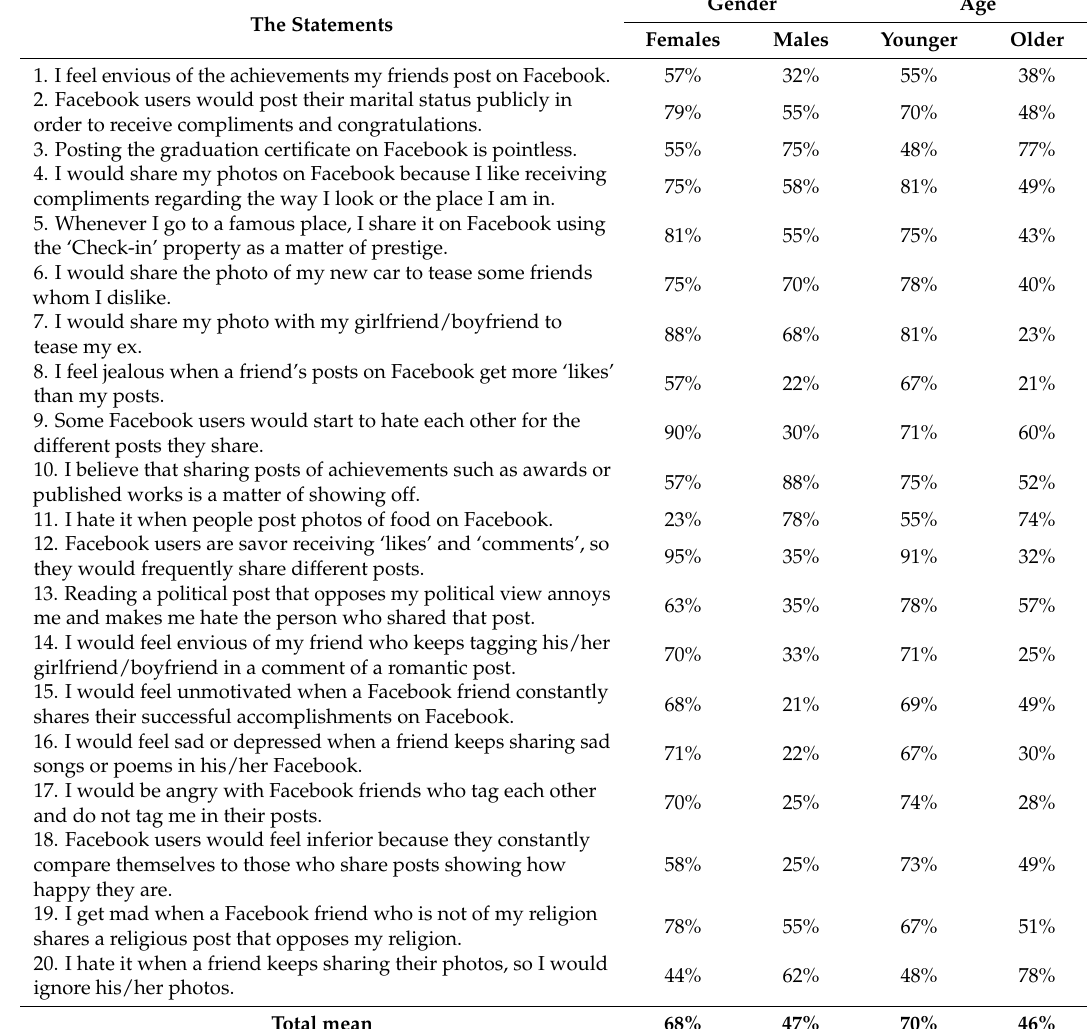
Table 2. Percentages of the positive responses in each of the variables